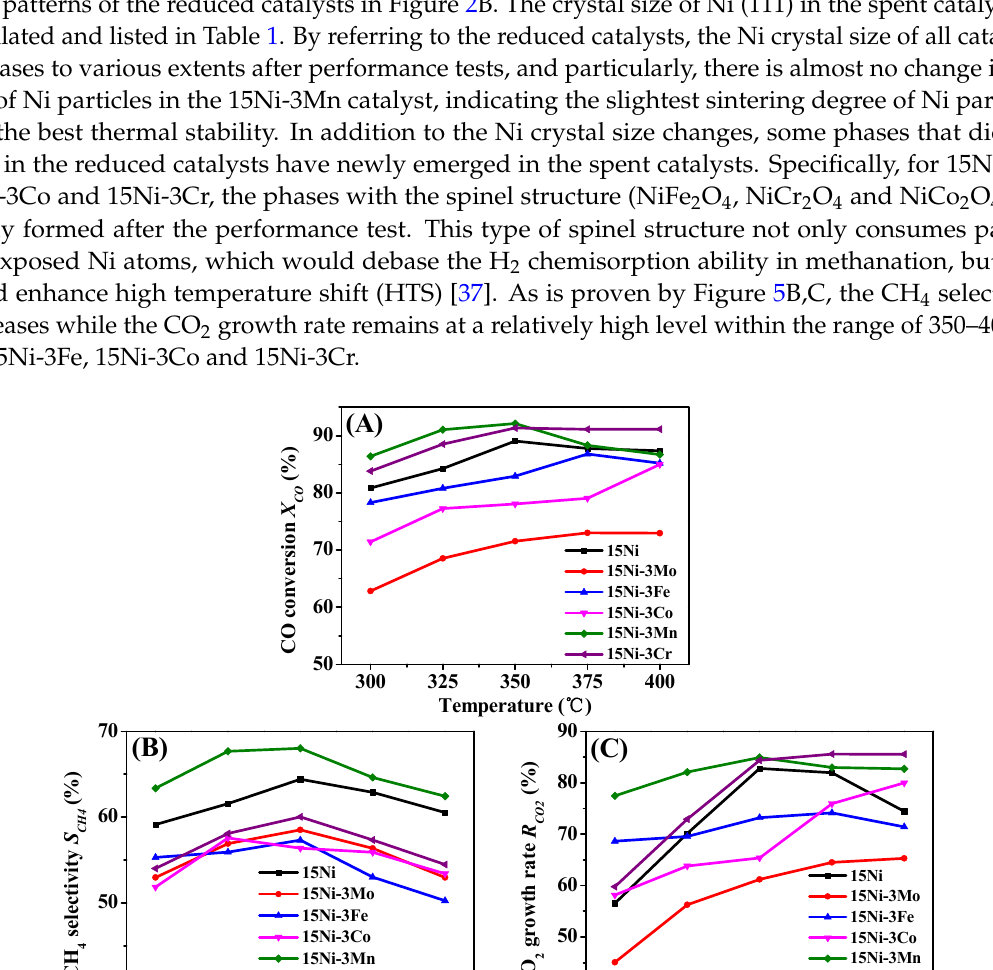
Figure 6. XRD patterns ( A ) and TG curves ( B ) of spent catalysts after performance tests: (a) 15Ni, (b) 15Ni ‐ 3Mo, (c) 15Ni ‐ 3Fe, (d) 15Ni ‐ 3Co, (e) 15Ni ‐ 3Mn and (f) 15Ni ‐ 3Cr. The quantity of deposited carbon on the spent catalysts was gauged by TG analysis, and the obtained results are depicted in Figure 6B. Generally, the TG curves can be classified into four sections: (1) Section I: the weight loss between room temperature and 280 °C mainly derived from absorbed surface water and volatiles compound; (2) Section II: weight gain between 280 and 450 °C due to the oxidation of Ni particles [30]; (3) Section III: weight loss originated from the oxidation of deposited α‐ type carbon (C α ) between 450 and 670 °C; and (4) Section IV: weight loss ascribed to the oxidation of β‐ type carbon (C β ) plus graphitic carbon (Cc) above 670 °C [24]. According to the literature [24,38], C α is the active species formed by CO dissociation, which is the essential intermediate for the formation of methane, and C β is one kind of polymeric carbon species that can be produced by C α reacting. Cc is normally generated at high temperatures that can be transformed from C β , whereas it is responsible for the deactivation of catalysts. Relevant simplified formulas are inserted in Figure 6B. The carbon deposition rate is also compiled in Table 2. As is shown, except for